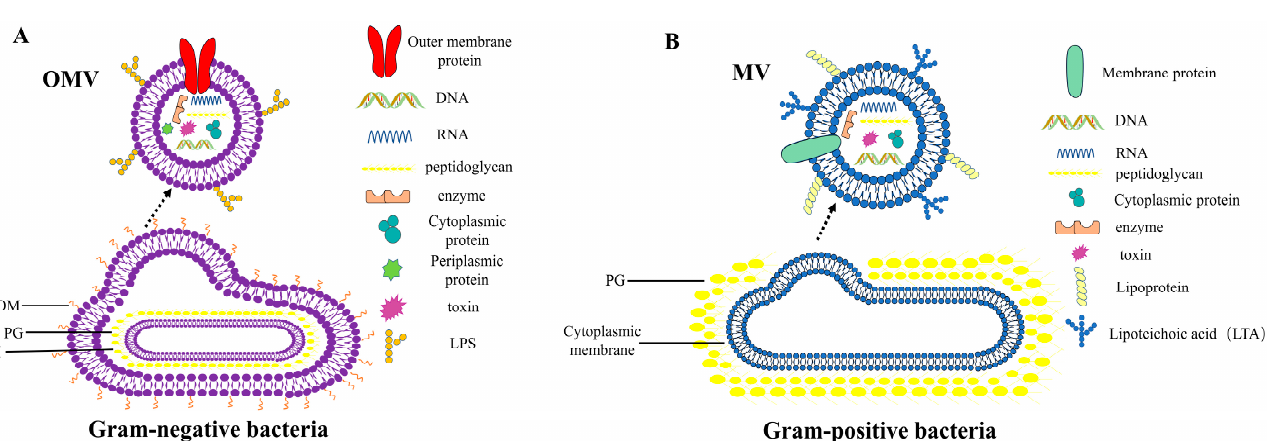
Figure 2. Different pathways for the biogenesis of BMVs. 3.1. Biogenesis of OMVs